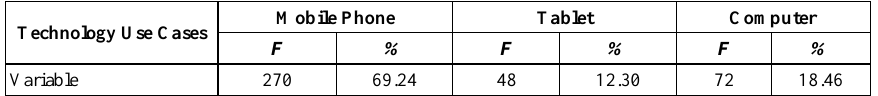
Table 4. Technology usage status of university students